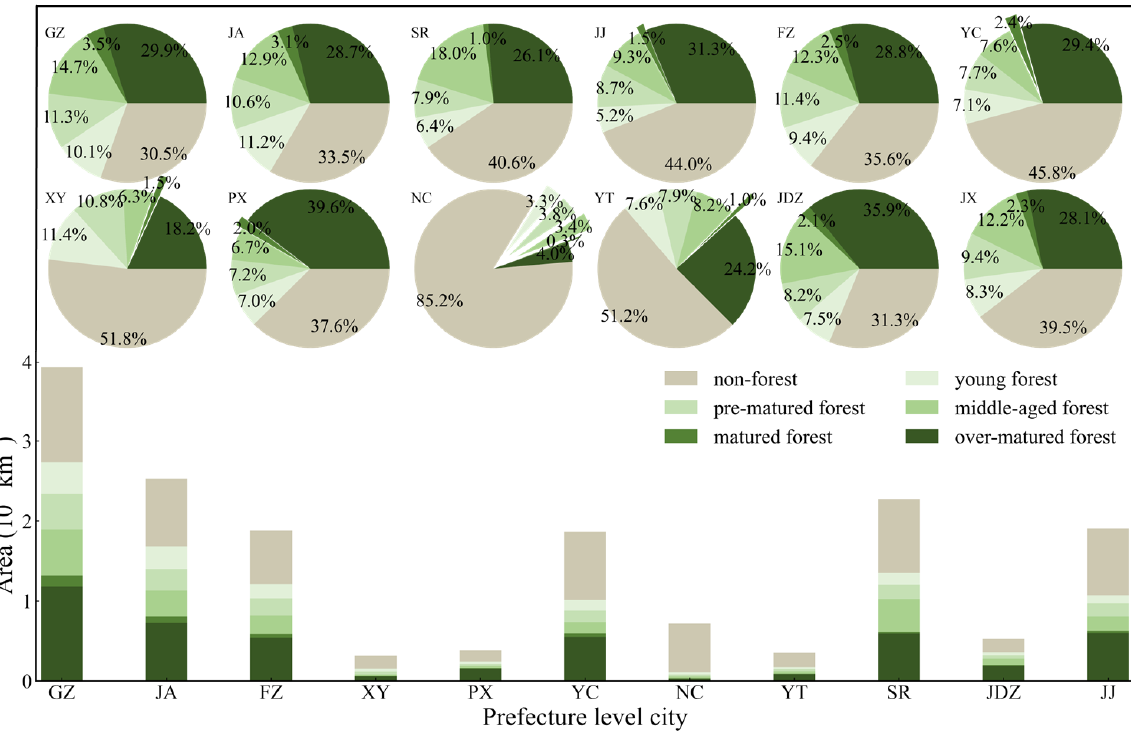
Figure 9. Forest area age groups for prefecture-level city